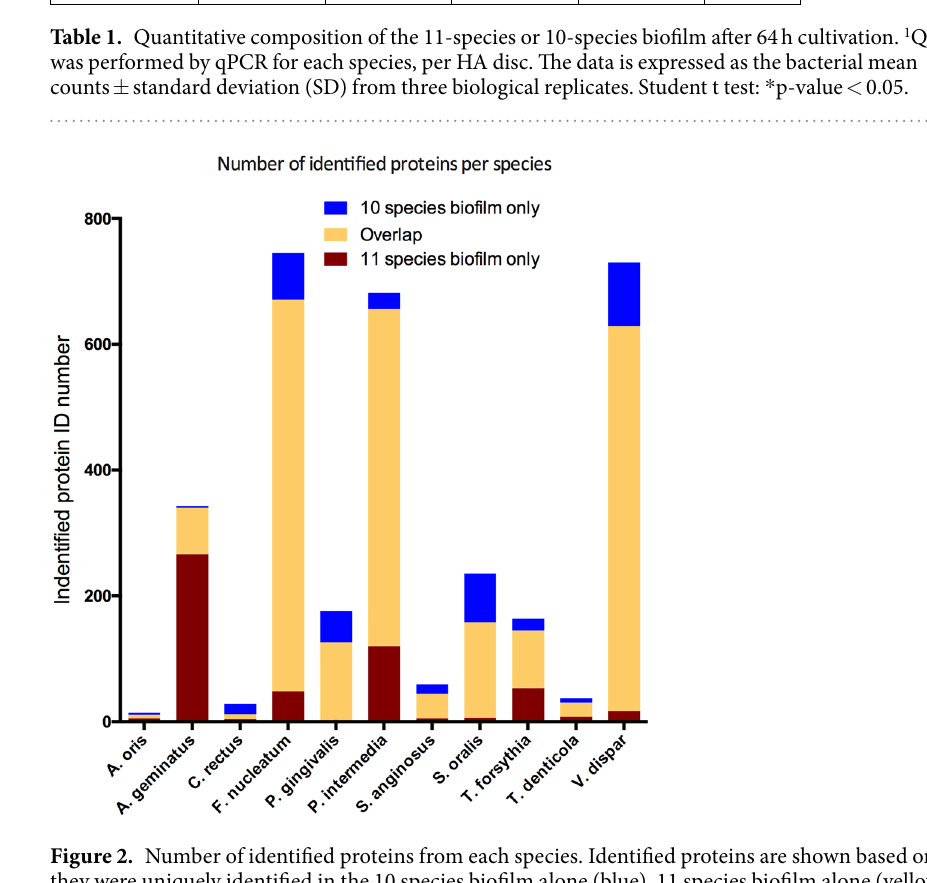
Figure 2. Number of identified proteins from each species. Identified proteins are shown based on whether they were uniquely identified in the 10 species biofilm alone (blue), 11 species biofilm alone (yellow), or in both groups